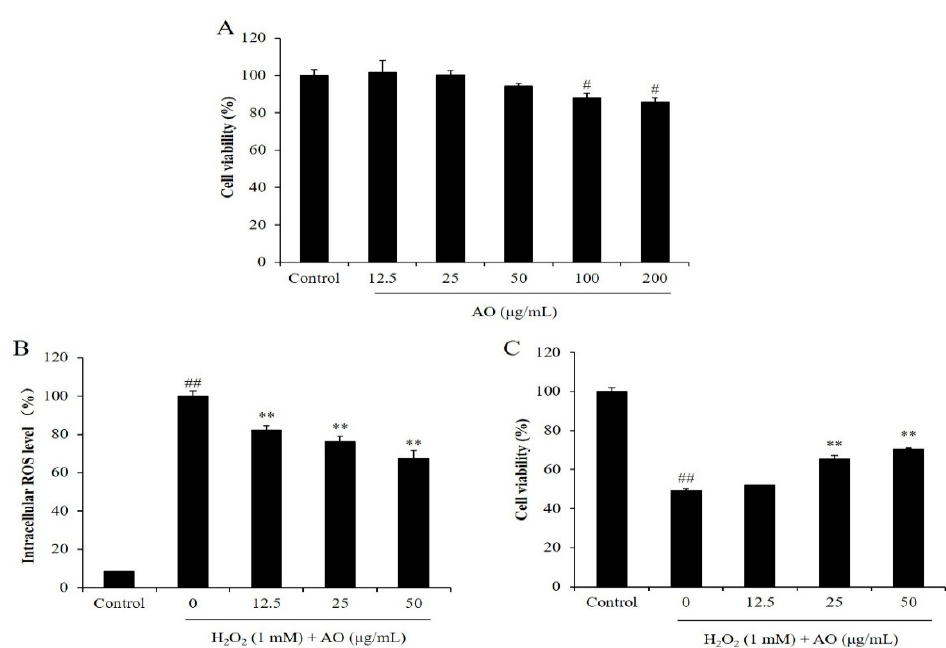
Figure 1. The effect of AO on H 2 O 2 -stimulated oxidative damage in Vero cells. ( A ) Cytotoxicity of AO on Vero cells; ( B ) the intracellular ROS levels of H 2 O 2 -stimulated Vero cells; ( C ) the viability of H 2 O 2 -treated Vero cells. # p < 0.05 and ## p < 0.01 as compared to the control group. ** p < 0.01 as compared to the H 2 O 2 -treated group.